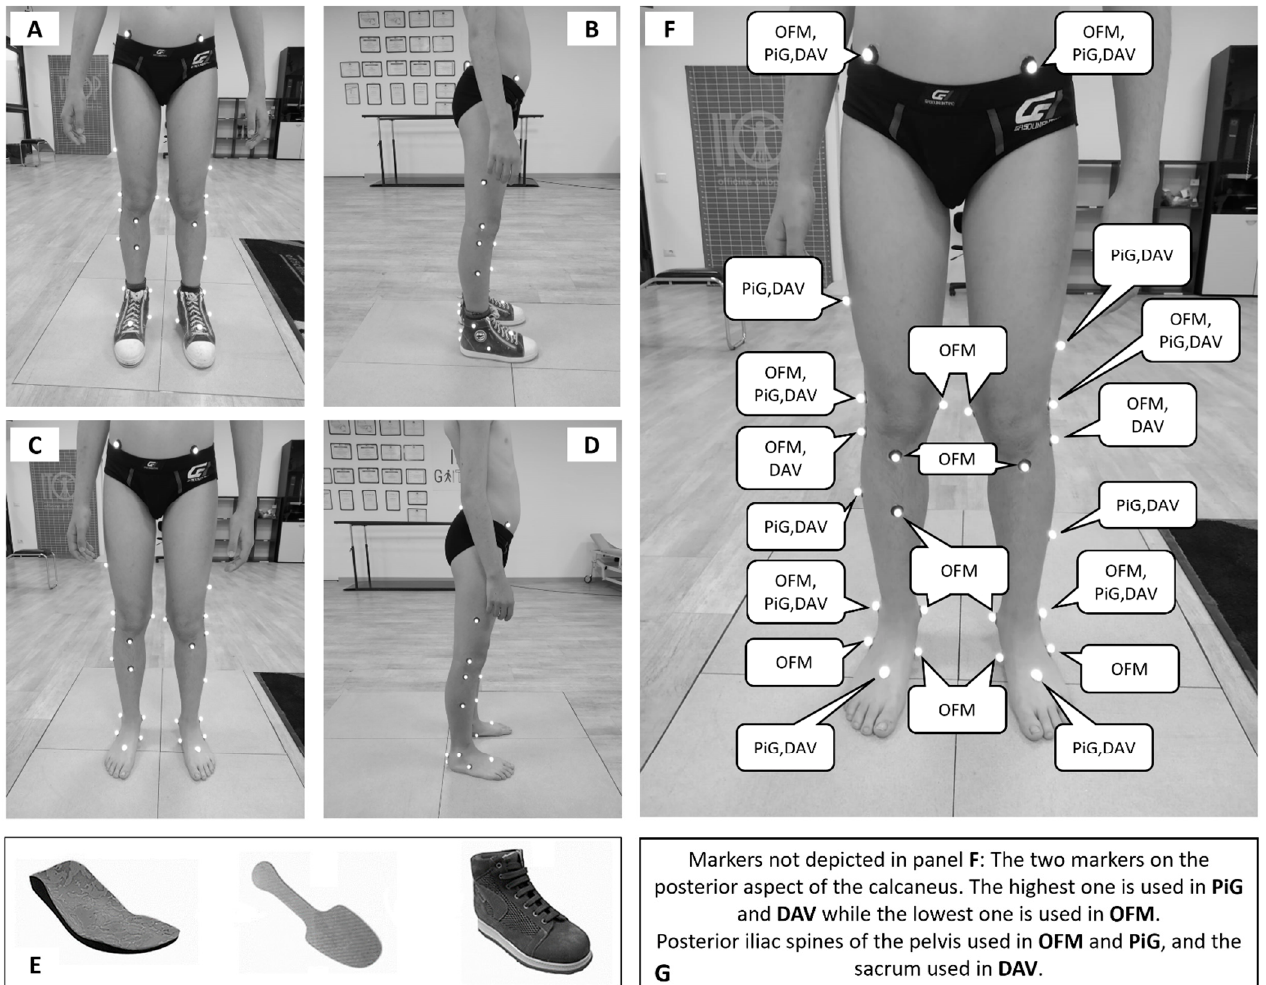
Figure 1. Front and lateral view of the used marker set while wearing the foot orthosis ( A and B , respectively) and in barefoot condition ( C and D , respectively). Bottom ( E ): representation of the A. Dyn.O. ® orthosis. From left to right: foot orthosis, carbon fiber flexible plate, orthopedic shoe. ( F ) Graphical representation of markers used in the different models, with specification ( G ) for the markers not depicted in panel ( F ). Relevant coordinate systems are described in the Supplementary Material.